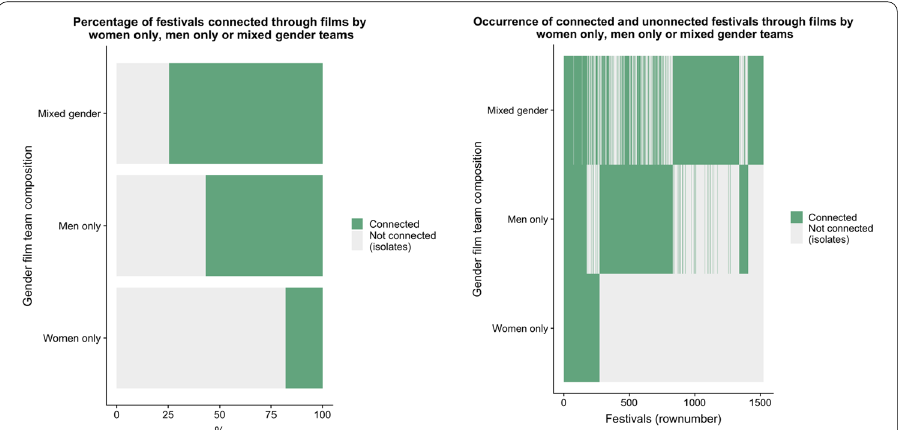
Fig. 3 Connectedness of festivals through films made by women-only, men-only, and mixed core creative